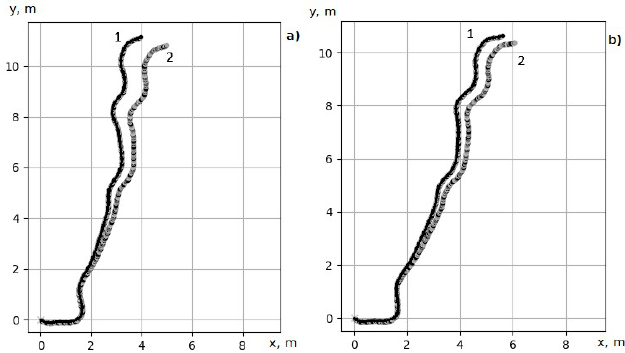
Fig. 9. Trajectories calculating heading based on the a) gyroscope and b) encoder values (prediction length of 1200), where 1 – actual trajectory and 2 – forecasted trajectory from the stacked LSTM